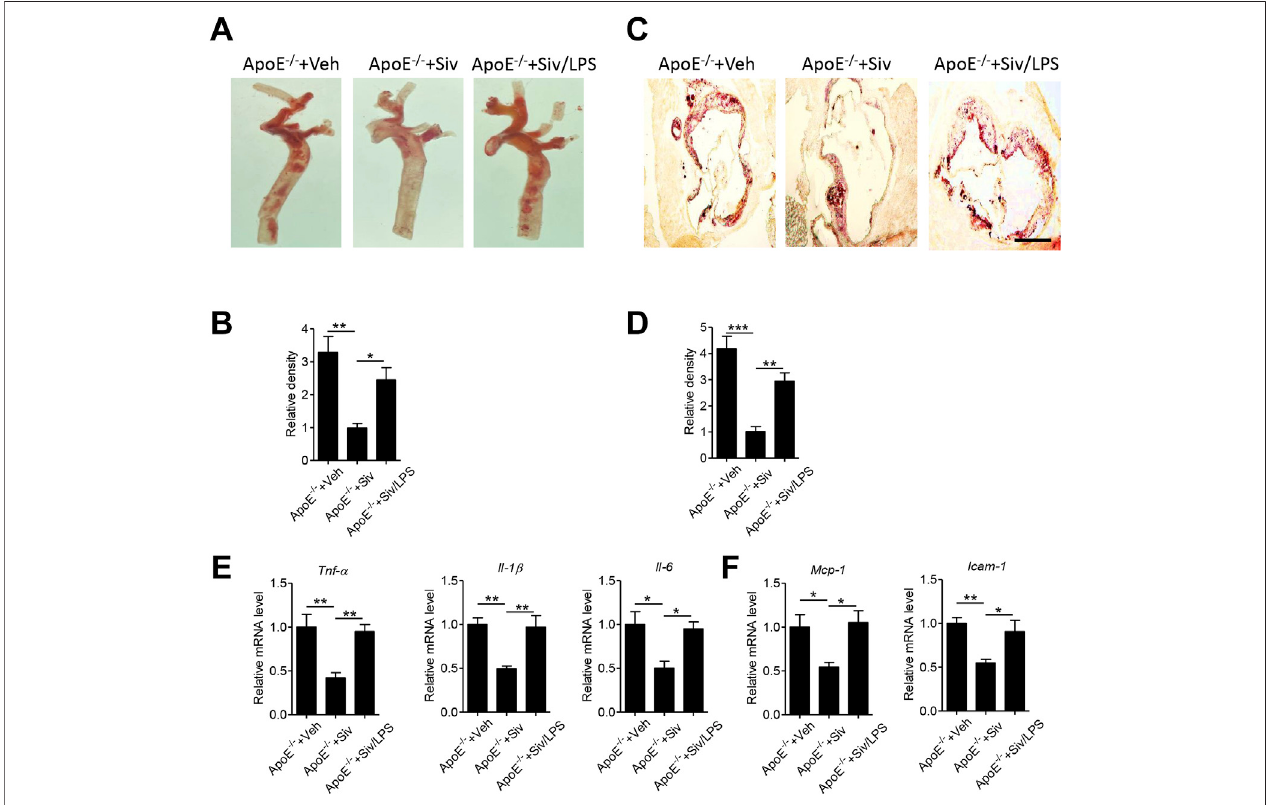
FIGURE5| Administration oflipopolysaccharides eliminatesanti-atheroscleroticbene fi tsofsivelestatinApoE -/- mice.Male ApoE -/- micewerefedwithHFHCdiet for 4 weeks and then treated with sivelestat (Siv, 50 mg/kg per day, intraperitoneal injection) and LPS (25 μ g/day, subcutaneous injection) or Veh for 8 weeks. (A – B) Oil RedOstainingofenfaceaorta (A) andthequantitativeanalysisofrelativelipiddensity (B) . (C – D) OilredOstainingoftheaortaroot (C) andthequantitativeanalysisofthe relative lipid density (D) . Scale bar = 200 μ m. (E – F) Real-time PCR analysis of gene levels of in fl ammatory cytokines (E) , including Tnf- α , Il-1 β , and Il-6 , and chemokines (F) including Mcp-1 and Vcam-1 . Data are shown as mean ± SEM. n = 6 mice/group and * p < 0.05, ** p < 0.01, *** p <